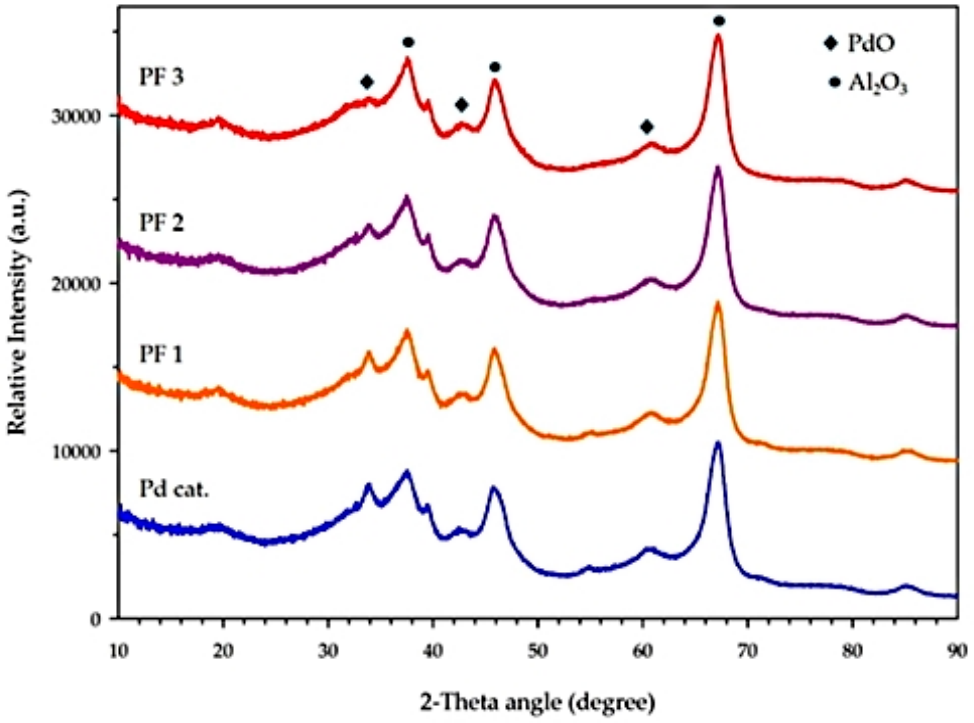
Figure 3. The XRD patterns (Pd cat, PF1, PF2, PF3) of PdO and Al 2 O 3 catalysts analysed by X-ray diffractometer.